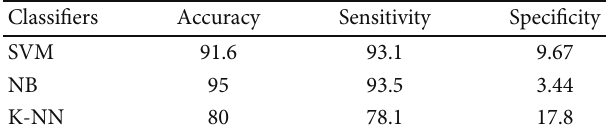
Table 2: Performance measures (%).